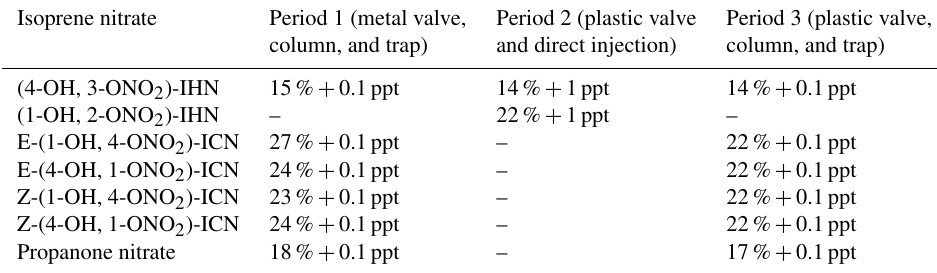
Table 1. Uncertainties in the measurements of the isoprene nitrates. Isoprene nitrate Period 1 (metal valve, Period 2 (plastic valve Period 3 (plastic valve, column, and trap) and direct injection) column, and trap) (4-OH, 3-ONO 2 )-IHN 15% + 0.1ppt 14% + 1ppt 14% + 0.1ppt (1-OH, 2-ONO 2 )-IHN – 22% + 1ppt – E-(1-OH, 4-ONO 2 )-ICN 27% + 0.1ppt – 22% + 0.1ppt E-(4-OH, 1-ONO 2 )-ICN 24% + 0.1ppt – 22% + 0.1ppt Z-(1-OH, 4-ONO 2 )-ICN 23% + 0.1ppt – 22% + 0.1ppt Z-(4-OH, 1-ONO 2 )-ICN 24% + 0.1ppt – 22% + 0.1ppt Propanone nitrate 18% + 0.1ppt – 17% +